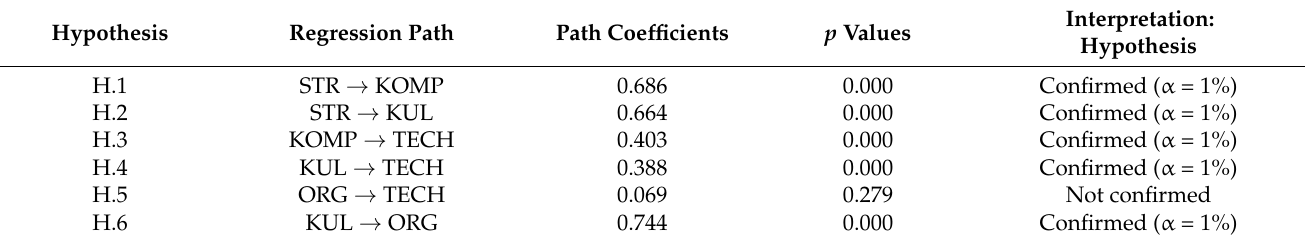
Table 6. Path coefficients and significance of relations between